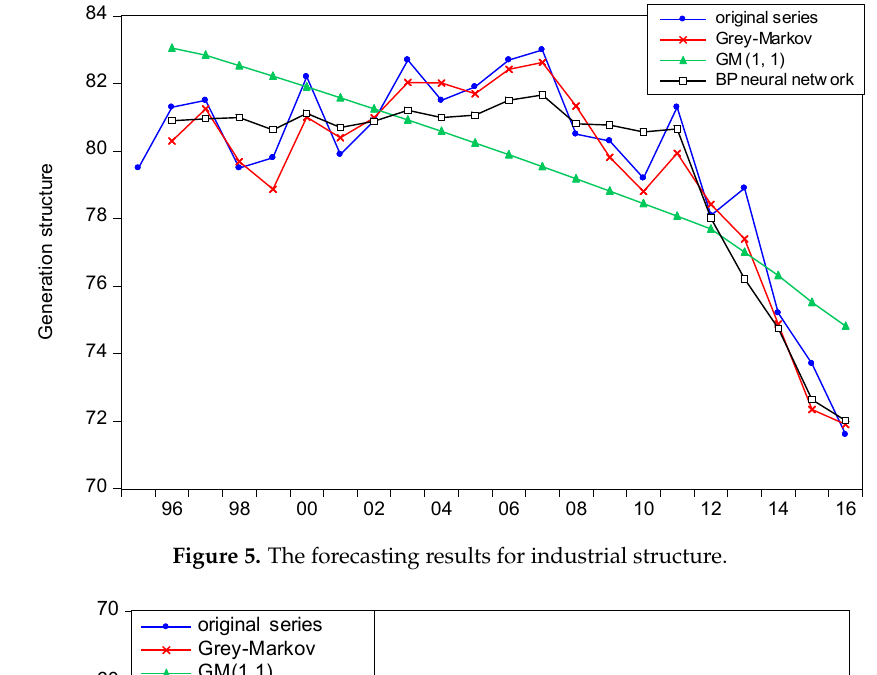
Figure 5. The forecasting results for industrial structure.